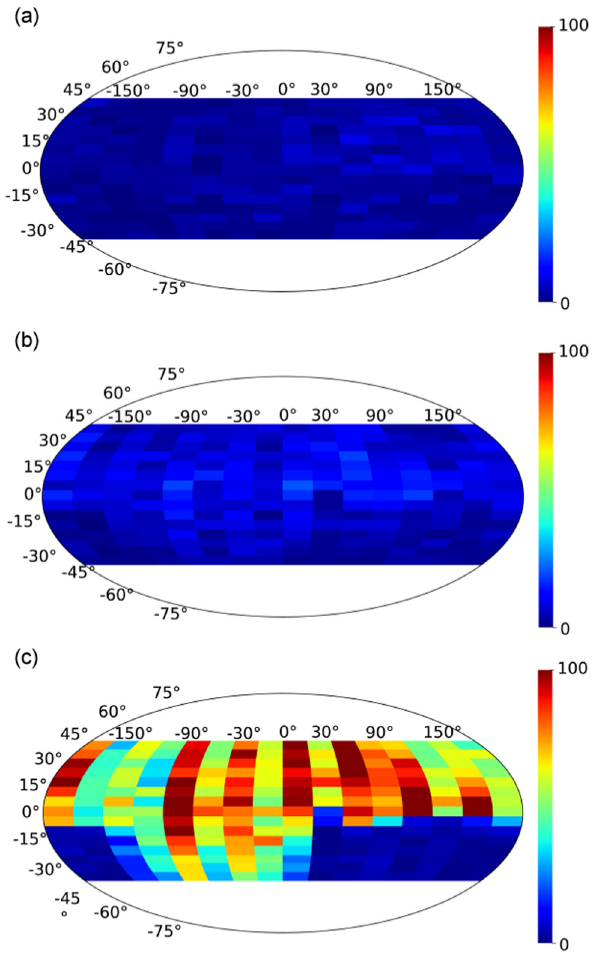
Figure 7: Raw data from on - orbit measurement in the instant time of 0.2 s for ( a ) 584 eV energy bin with 8.5% bandwidth, ( b ) 4,000 eV energy bin with 8.5% bandwidth, and ( c ) 22,666 eV energy bin with 8.5%